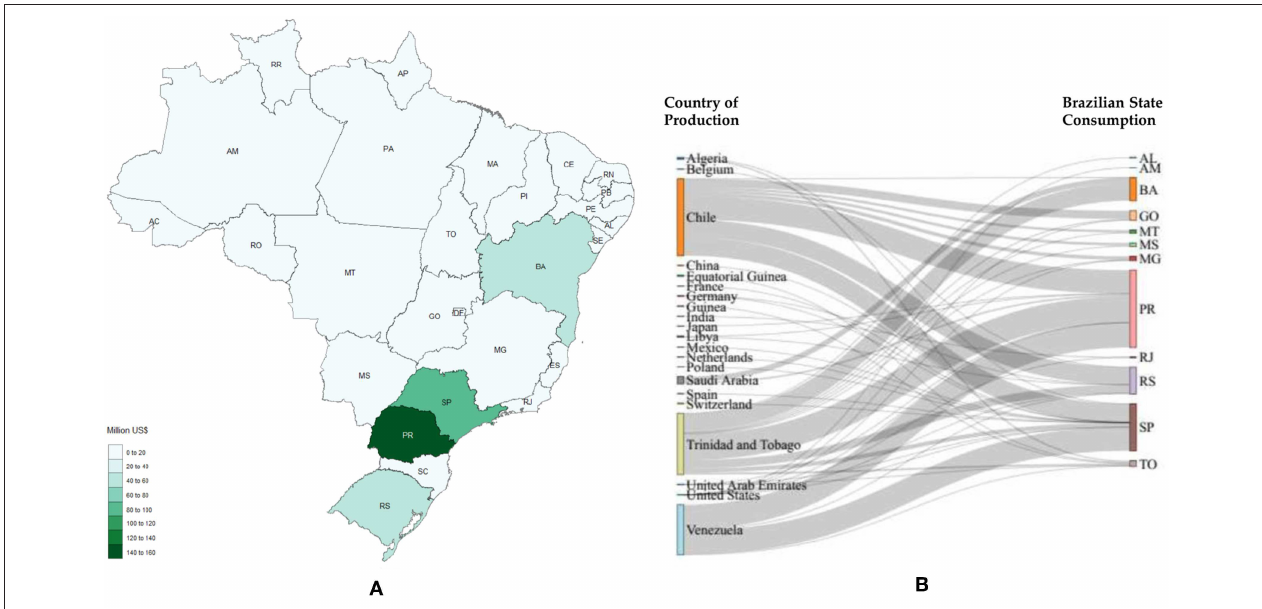
FIGURE 8 | Methanol imports. (A) Local needs considering 2017; (B) Stratification for 2017, countries on the left represent the origin of the product studied and the states on the right represent the destination (AL, Alagoas; AM, Amazonas; BA, Bahia; GO, Goiás; MT, Mato Grosso; MS, Mato Grosso do Sul; MG, Minas Gerais; PR,